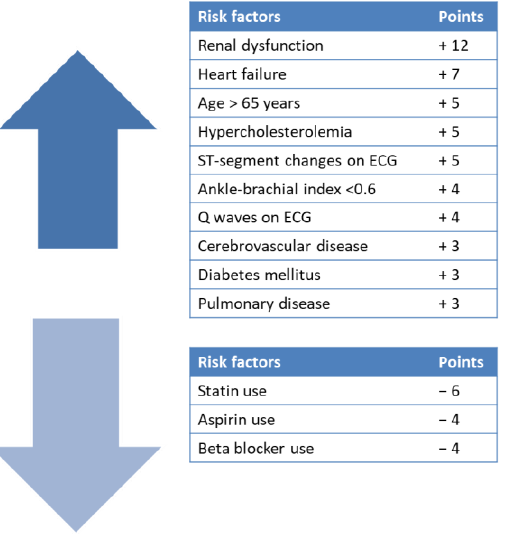
Figure 2. Risk index for 10-year mortality rates in patients with PAD (adapted after [11]) .